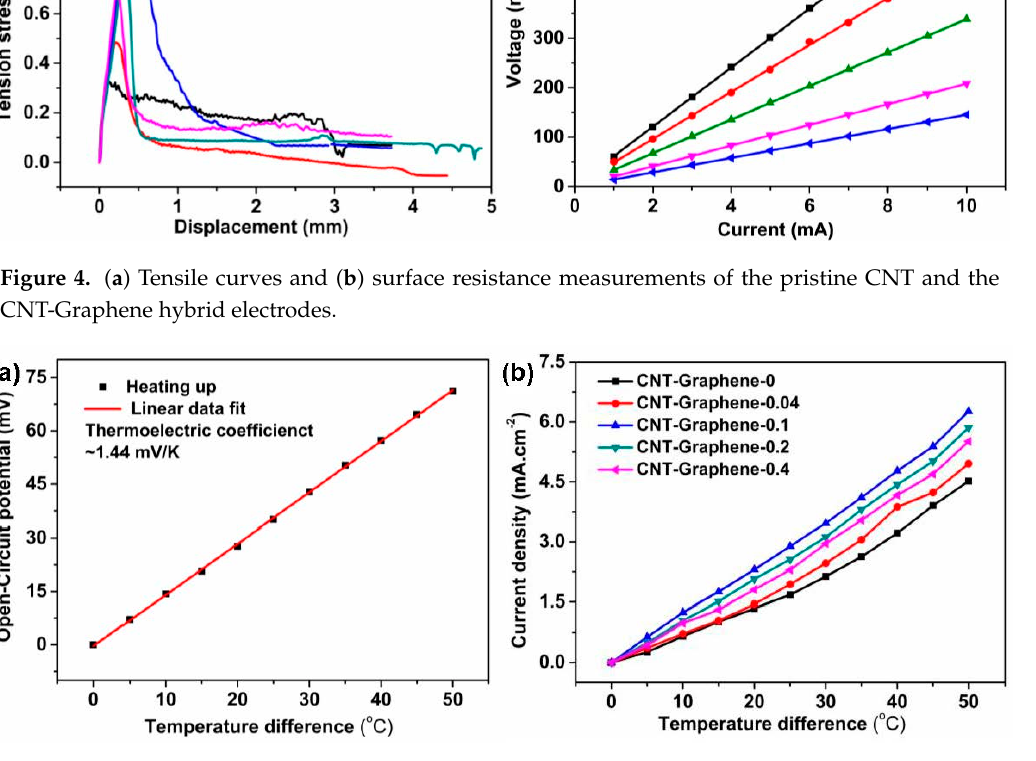
Figure 5. ( a ) Cell potential versus temperature difference, and ( b ) current density versus temperature difference of the pristine CNT and CNT-Graphene hybrid electrodes, each electrode surface area is 0.36 cm 2 .